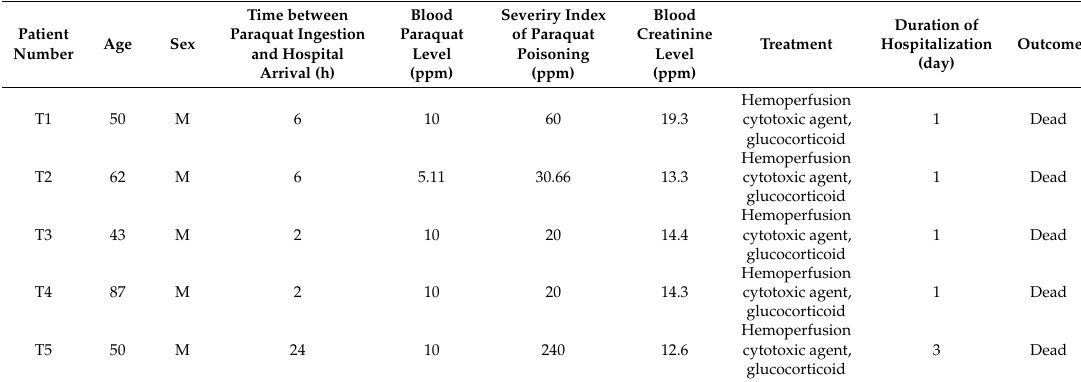
Table 2. Clinical data of patients with PQ intoxication (n =